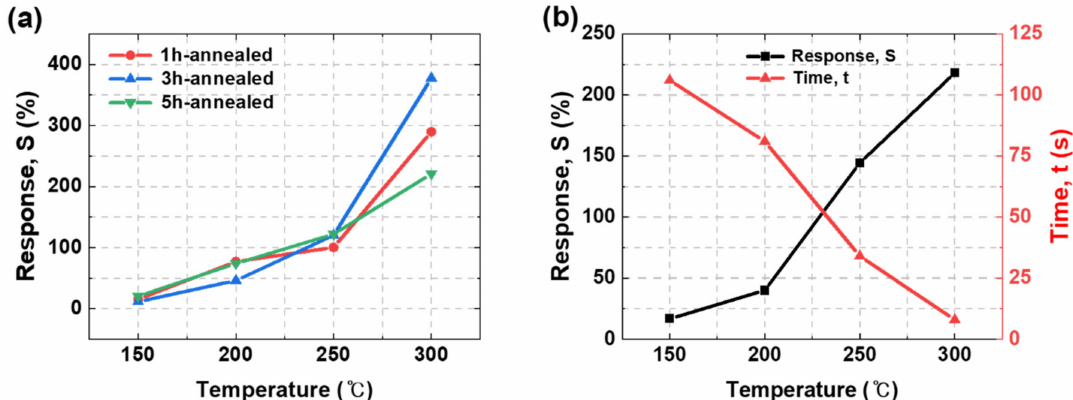
Figure 8. ( a ) Comparison of response according to the operating temperature of sensors fabricated under different annealing conditions. ( b ) Comparison of sensitivity and response time according to sensor operating temperature of H 2 sensor fabricated by annealing for 3